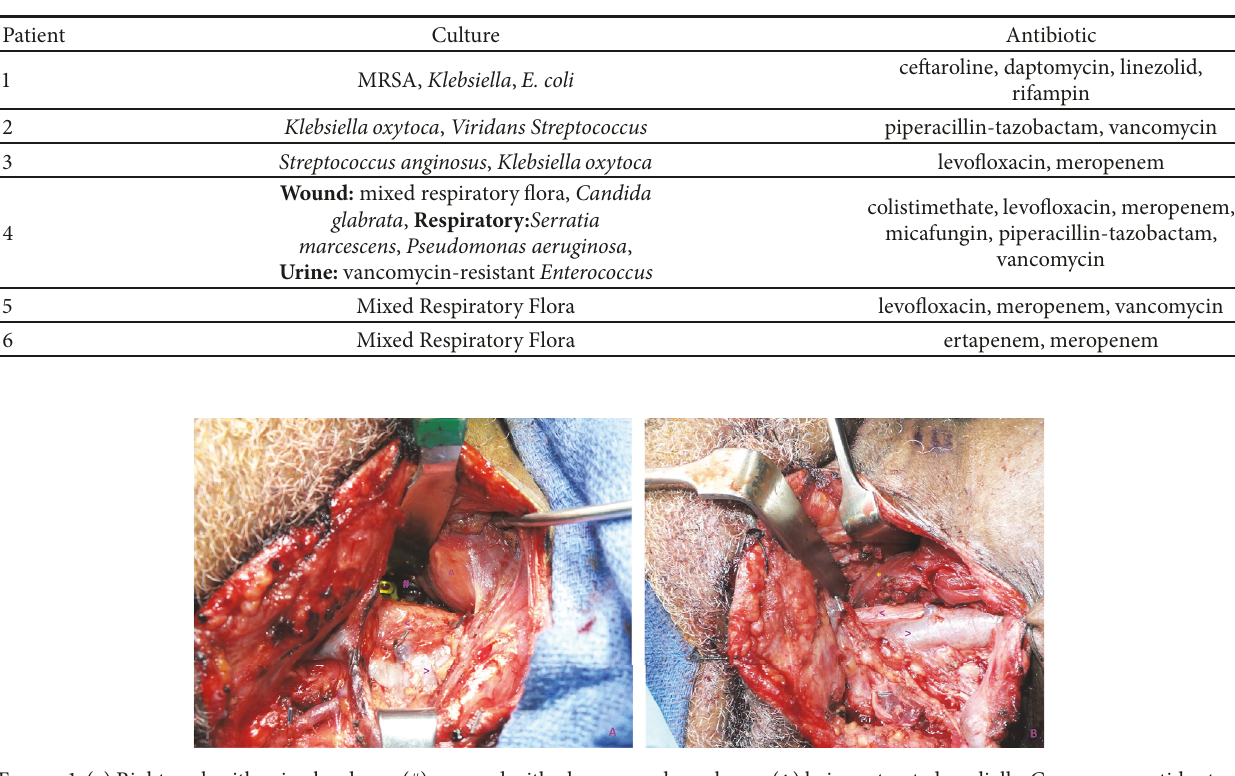
Table 3: Summary of patient cultures and antibiotic therapies.